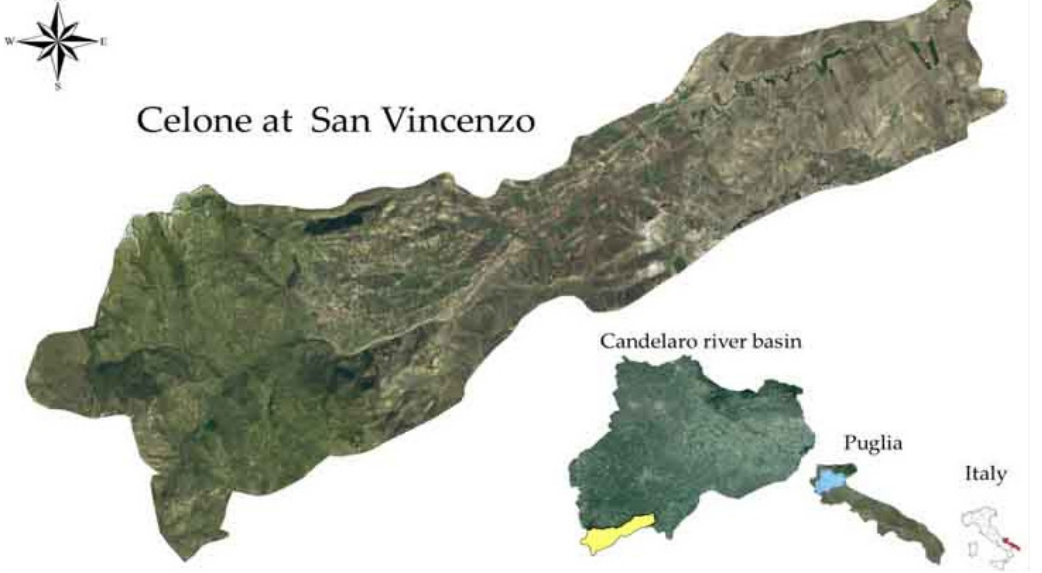
Figure 2. Location of the Celone at San Vincenzo watershed.